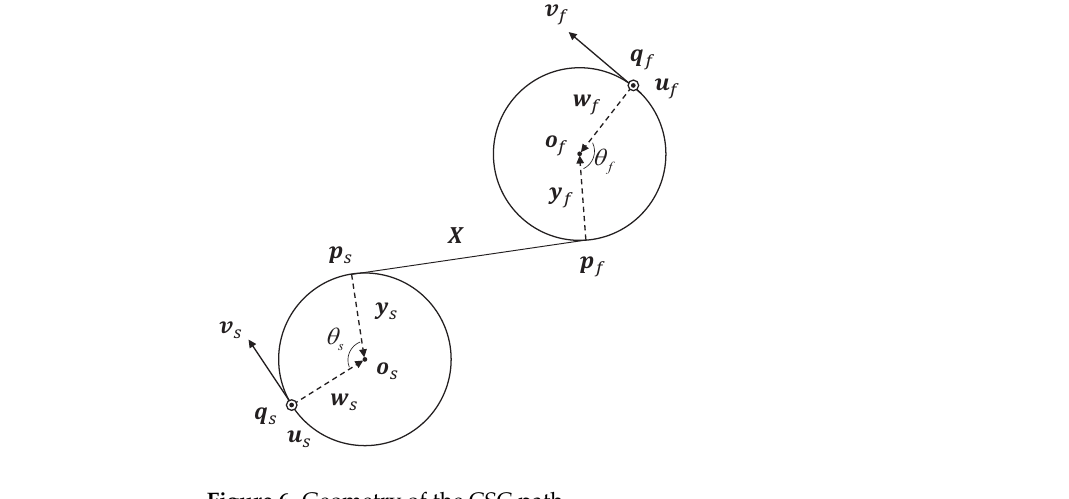
Figure 6. Geometry of the CSC